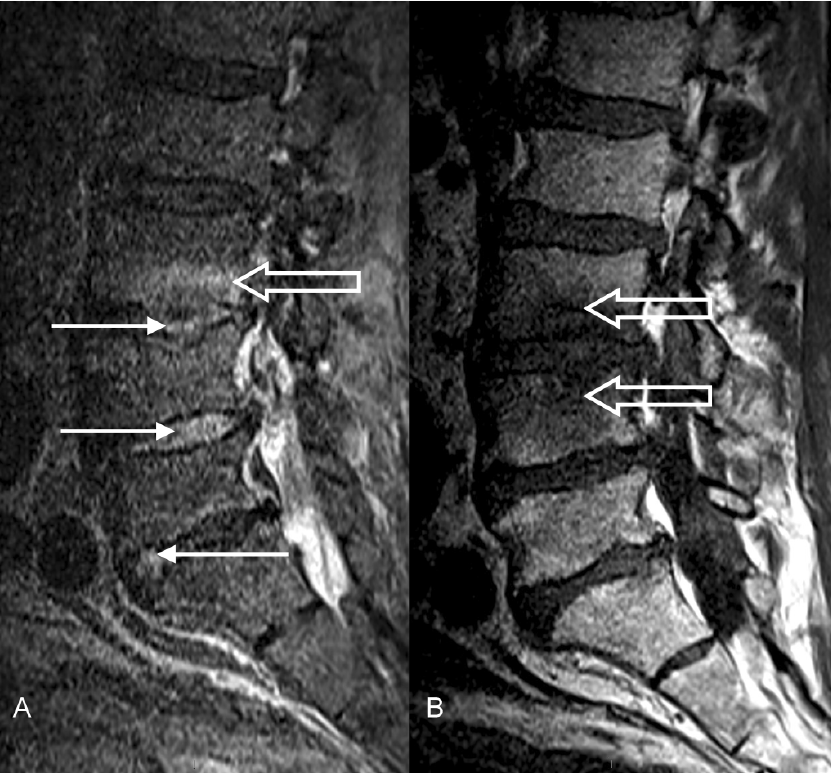
Figure 1 : Magnetic resonance imaging of the lumbar spine. A: T2 Fat suppressed - weighted magnetic resonance imaging of the lumbar spine showing global (L4-L5) or focal (L3-L4 and L5-S1) hyper intensity of the discus (little white arrows). Note the hyper intensity corresponding to the edema on the end-plate of the L3 vertebra (empty arrow). B: T1-weighted magnetic resonance showing abnormal hypo-intensity of the adjacent plate of the L3–L4 discus (empty arrows). Gadolinium injection was not performed and imaging procedure has been shortened due to the patient’s